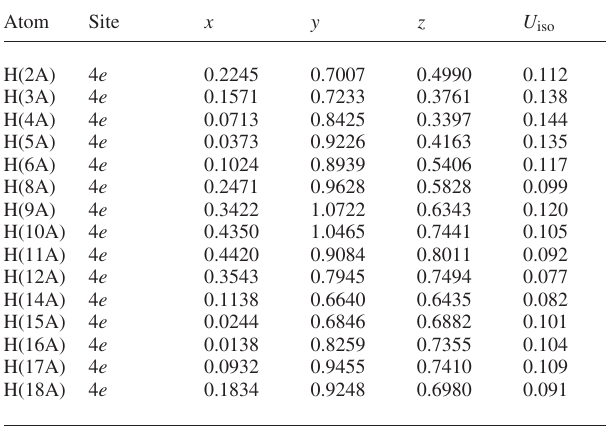
Table 2. Atomic coordinates and displacement parameters (in Å 2 )